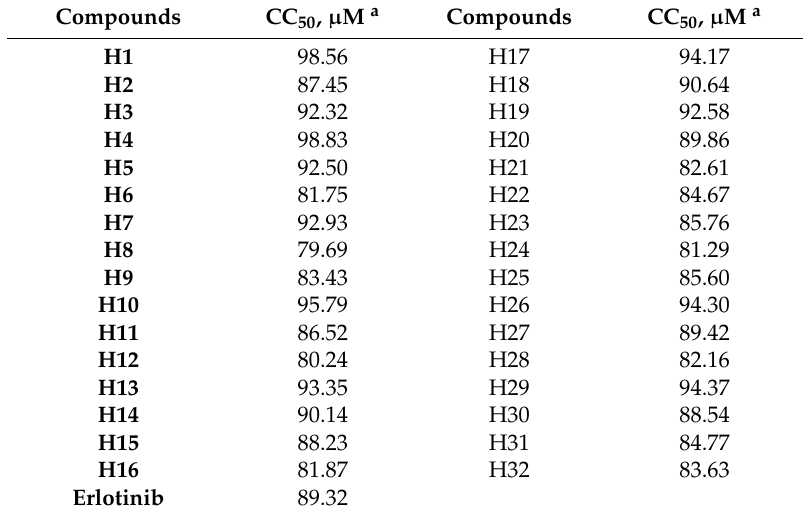
Table 4. The median cytotoxic concentration (CC 50 , µ M a ) data of tested